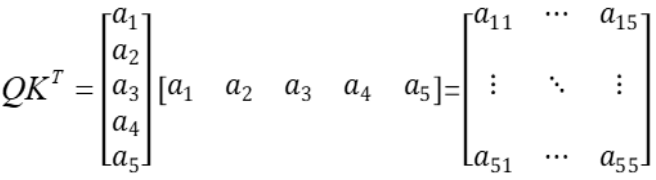
Figure 1. Similarity matrix in self-attention mechanism.